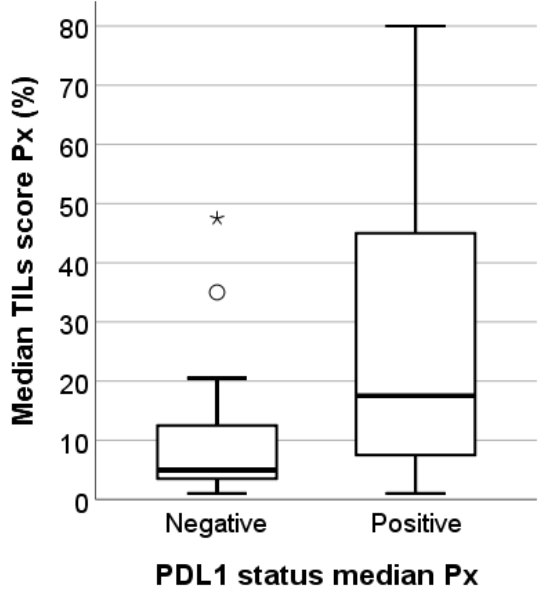
Figure 4. Box-and-whisker plot illustrating the median TILs scores Px for the PD-L1-negative and PD-L1-positive subgroups in this study cohort of 49 TNBC metastases. PD-L1-positive TNBC